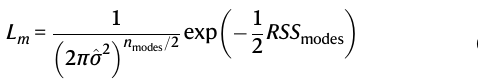
Figure3breportsthe Δ AICvalueforsolutionsobtainedby varying v